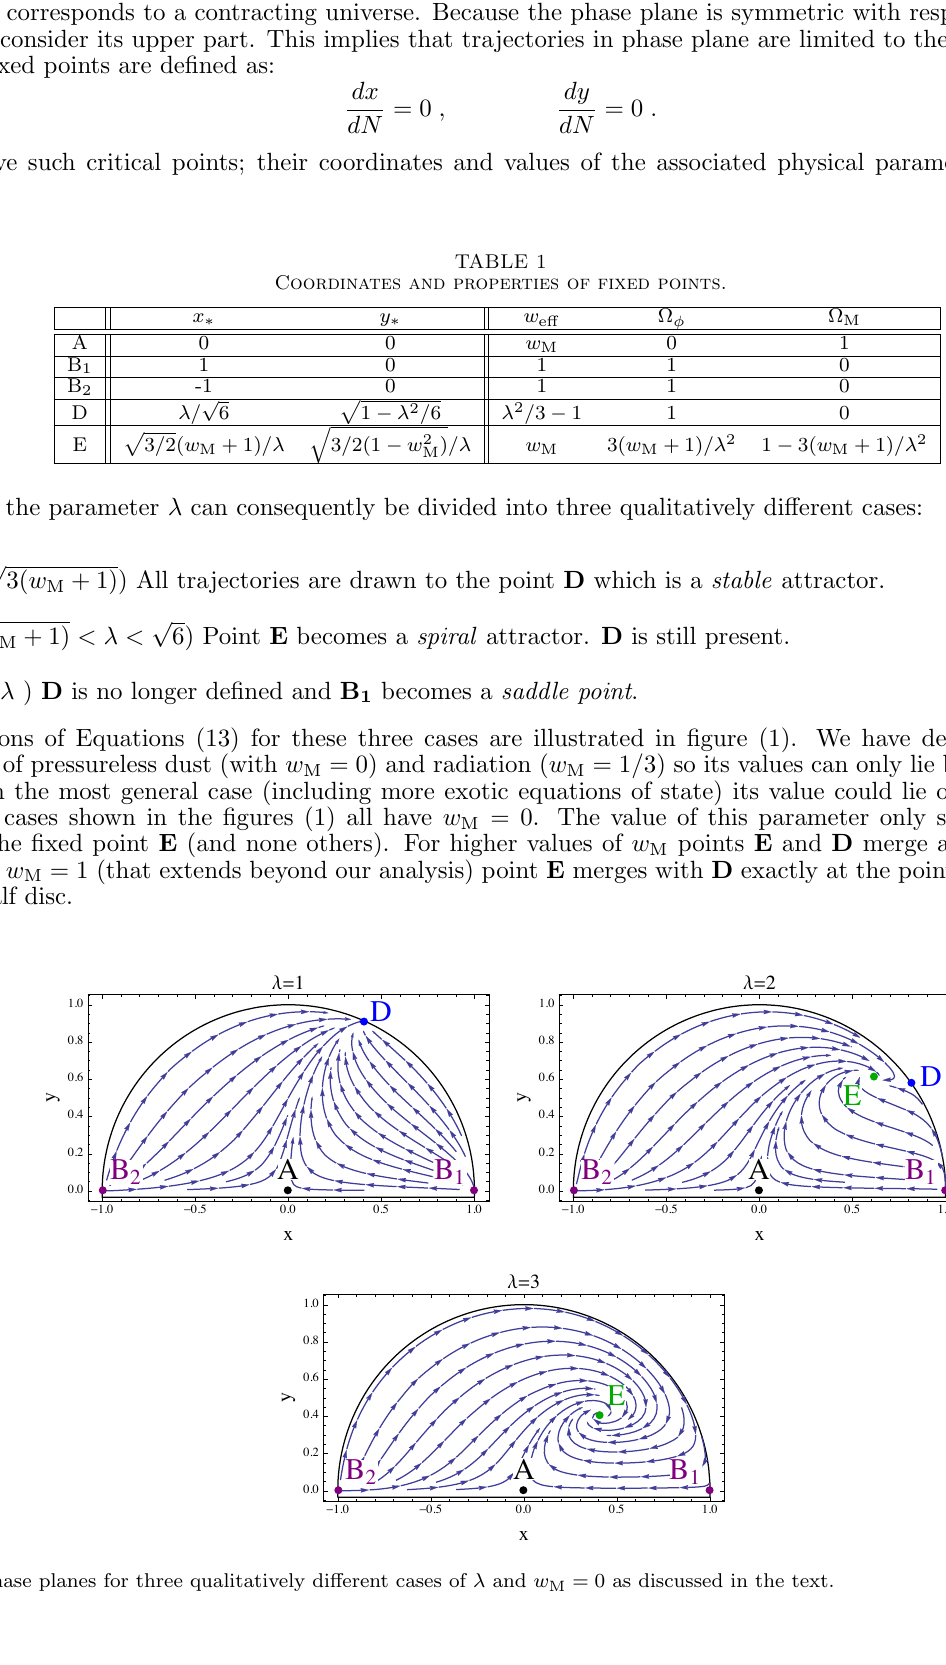
M = 0 as discussed in the